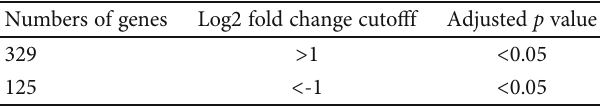
Figure 1: Di ff erentially expressed genes between recurrence and nonrecurrence samples, number statics, and functional enrichment. (a) Upregulated (red point ( N = 329 )) and downregulated (blue point ( N = 125 )) genes between recurrence and nonrecurrence samples, adjusted p value < 0.05, foldchange > 2 were selected as thresholds. (b) Di ff erentially expressed gene-enriched GO terms; a q value < 0.05 was selected as the threshold. (c) Di ff erentially expressed gene-enriched pathways; a q value < 0.05 was selected as the threshold. Table 1: Di ff erential expressed genes between the recurrence and nonrecurrence